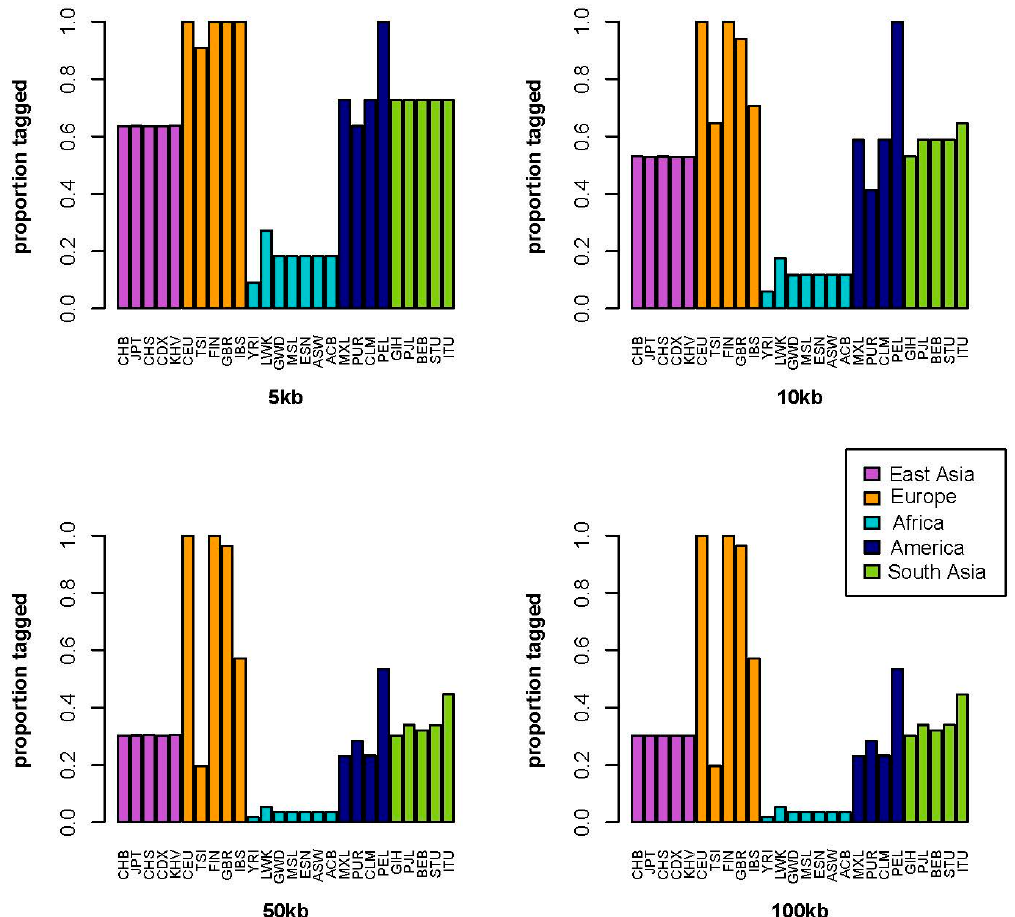
Figure 1. Coronary artery disease (CAD) genetic risk tag single nucleotide polymorphism (SNP) performance. Figure 1 displays four distance windows, each showing the proportion of correctly ( R 2 ≥ 0.08) tagged functional variants on the y -axis and each 1000 Genomes population sample on the x -axis. Population samples are color coded by continental region such that East Asia is purple, Europe is orange, Africa is turquoise, America is dark blue, and South Asia is green. Explanation of population sample abbreviations for the x -axis are shown in Table S1.